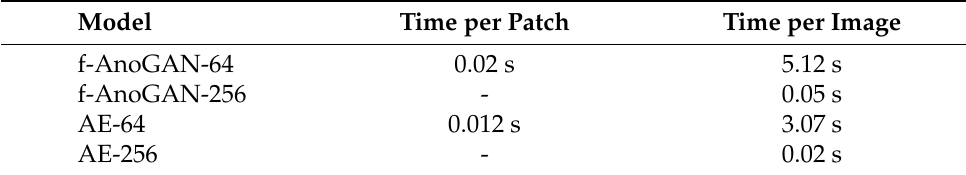
Table 4. Time required to process a cell for each